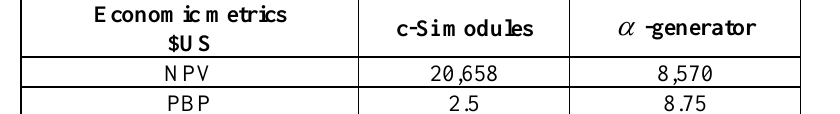
Table 4: Economic Assessment comparison between c-Si module and  -generator of 650W capacity systems. Economic metrics